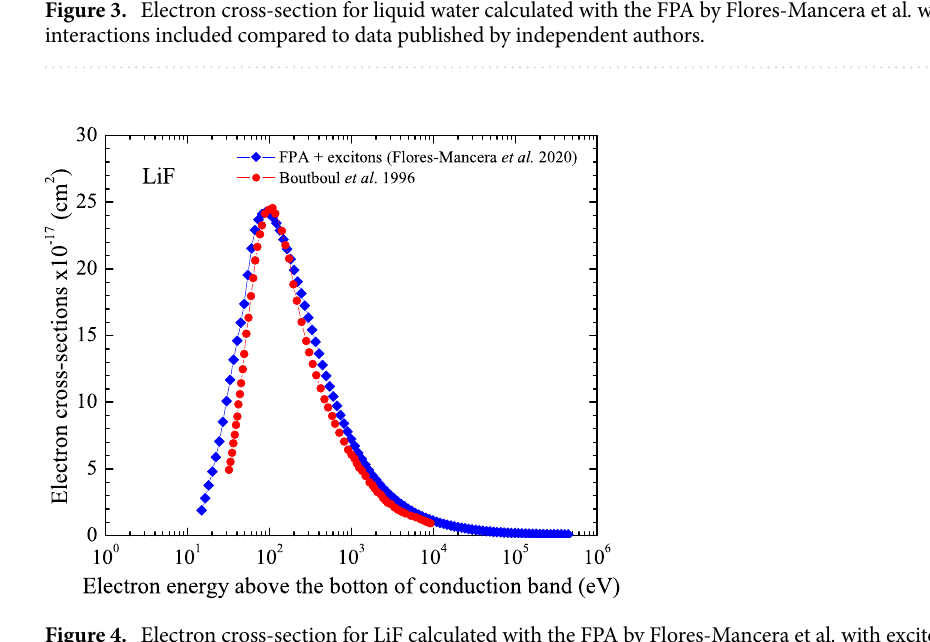
Figure 4. Electron cross-section for LiF calculated with the FPA by Flores-Mancera et al . with exciton interactions included compared to data published by independent